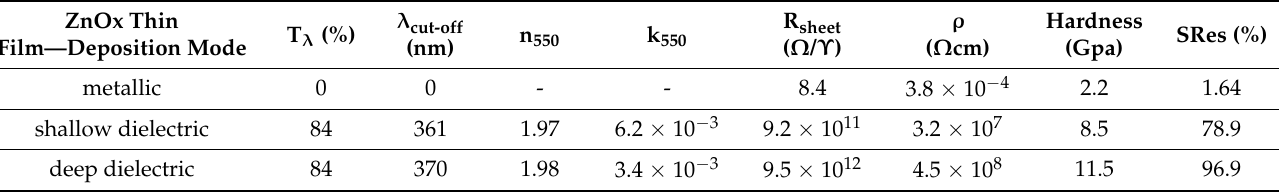
Table 2. Summary of the results of investigations for ZnOx thin